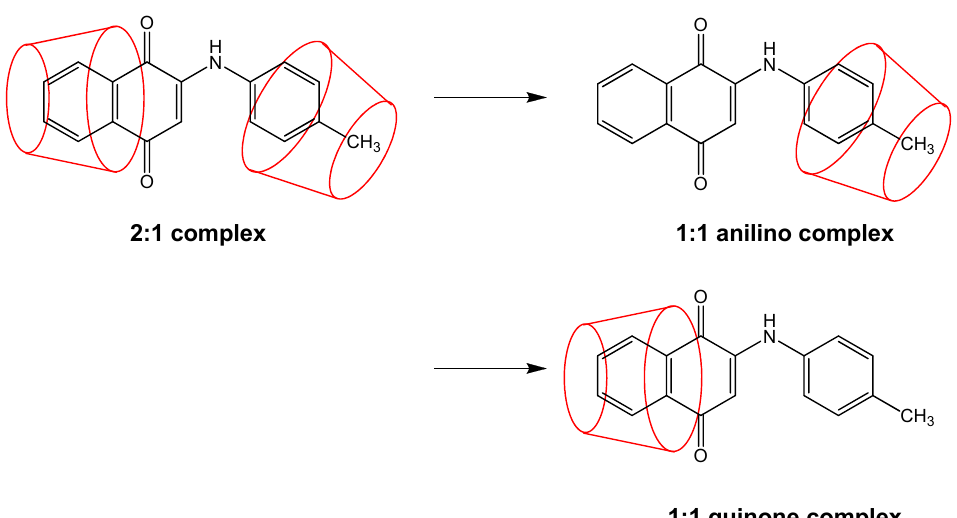
Figure 5. Hypothesis for the lack of observed 2:1 complexes in the case of most PAN derivatives: loss of one CD host to form 1:1 complexes, either anilino or quinone (consistent with the overall scheme shown in Figure 3).